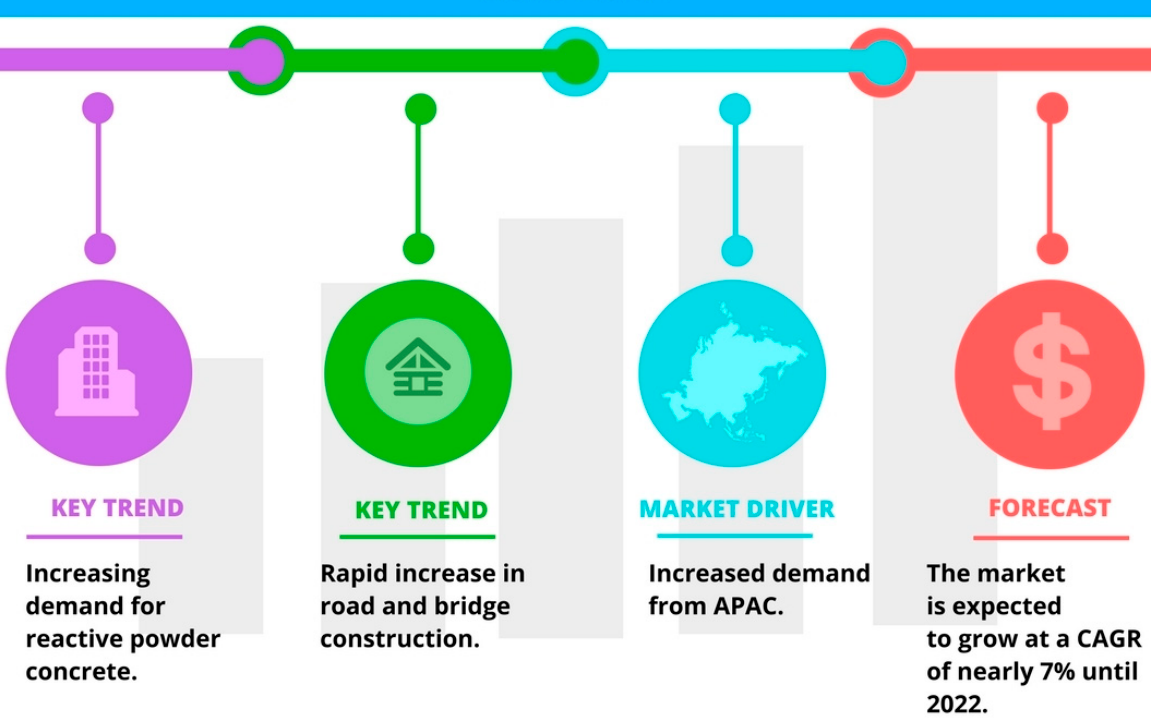
Figure 1. Global UHPC Market [59] .